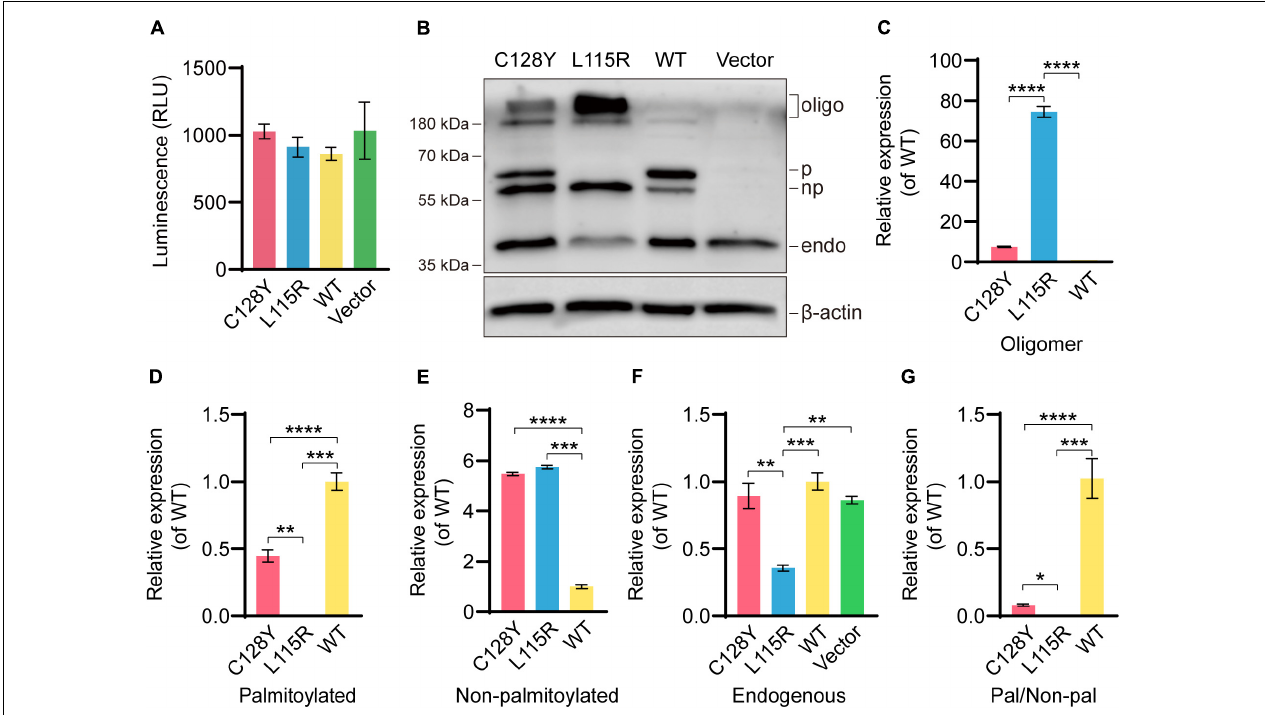
FIGURE 3 | Abnormal palmitoylation and oligomer formation due to C128Y mutation in vitro . (A) Both the C128Y and L115R mutations had no impact on cell viability. (B) The anti-CSP α antibody (Enzo life, ADI-VAP-SV003-E) used in this study can detect the band at around ∼ 34 kDa, the molecular weight for endogenous CSP α . The EGFP-tagged CSP α consisted of the amino acids of both EGFP (around 26 kDa) and CSP α and exhibited an apparent molecular weight of around 60 kDa. The palmitoylation process induced a shift in gel migration of approximately 7 kDa (67 kDa is the apparent molecular weight of the palmitoylated species). Furthermore, bands above 180 kDa represent oligomers of CSP α . The L115R mutation reduced the palmitoylation process and also enhanced the amount of oligomer formation. Similarly, but to a lesser extent, the C128Y mutation-induced decreased palmitoylation and triggered oligomer formation, but without impacting abundance detected in endogenous CSP α bands, as quantified in panel C (oligomer), (D) (palmitoylated CSP α ), (E) (non- palmitoylated CSP α ), (F) (endogenous CSP α ), and (G) (ratio of palmitoylated CSP α over non- palmitoylated CSP α ). N = 3, all data in the figure are shown as mean ± SEM, each group vs. WT. * P < 0.05, ** P < 0.01, *** P < 0.001, and **** P <